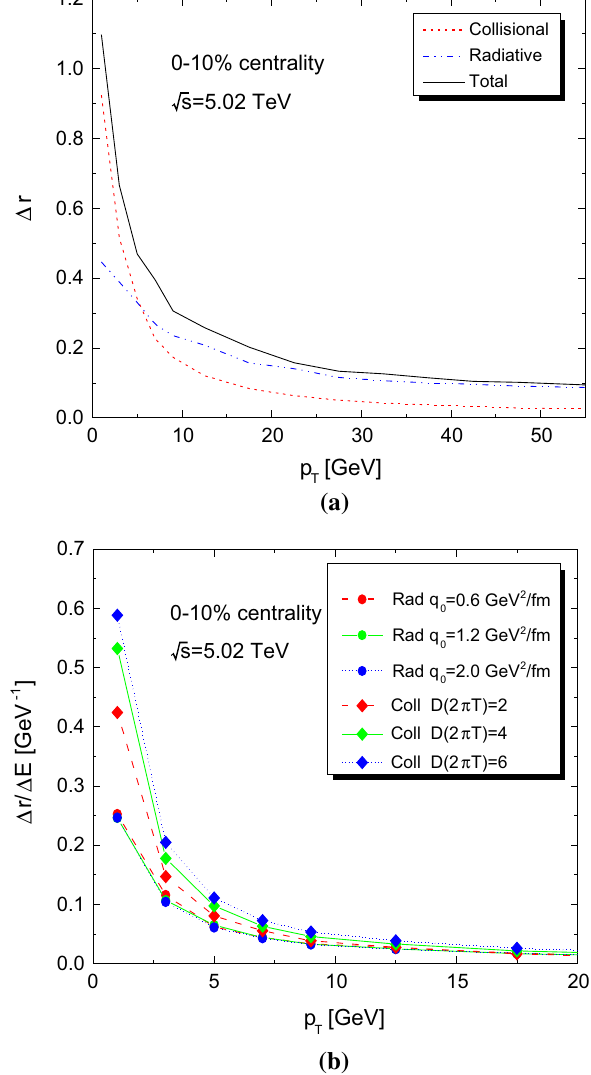
Fig. 6 a Angular deviation of charm quark relative to it’s initial direc- tionversustransversemomentum,theneteffectfromcollisionalprocess (red)andradiativeprocess(blue)aswellasthetotal(black)areshown. b Comparison of the ratio of angular deviation to energy loss as a function of transverse momentum, both for collisional and radiative, are shown with different